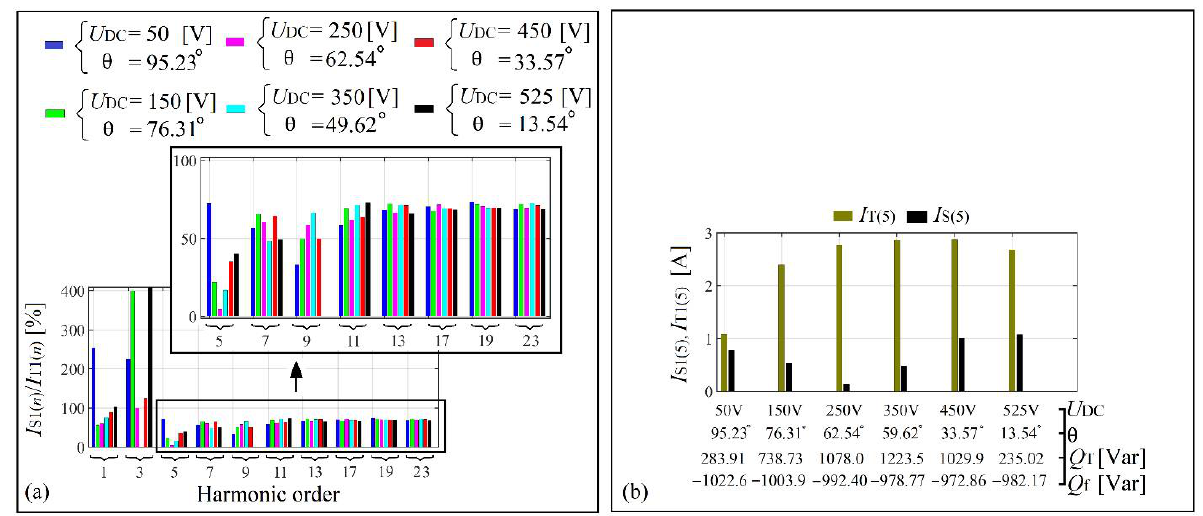
Figure 48. ( a ) Filter electiveness, ( b ) comparison between the 5th harmonic current of grid ( I S(5) ) and the input rectifier ( I T(5) ).